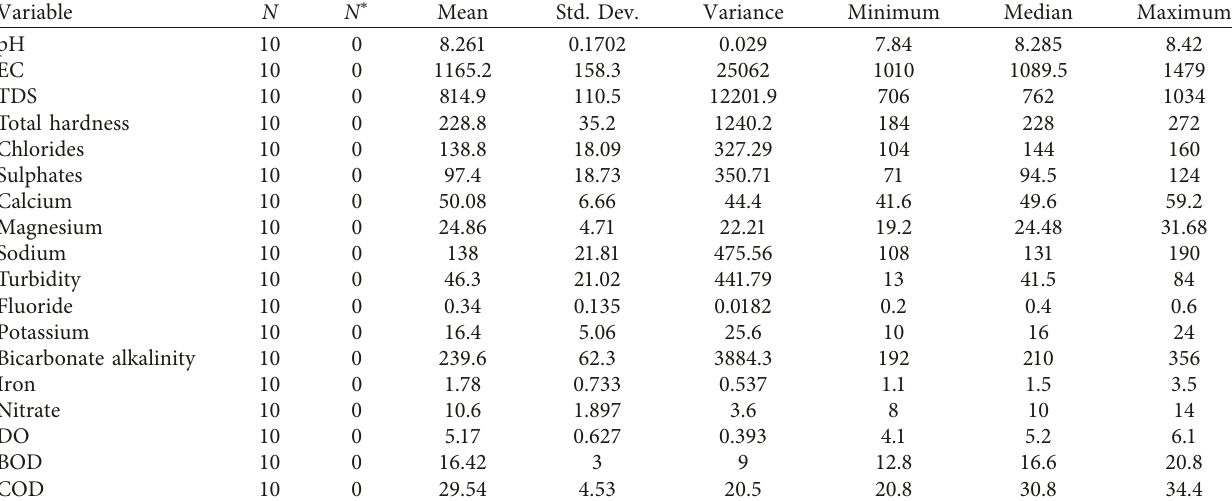
Table 5: Descriptive statistics of water quality